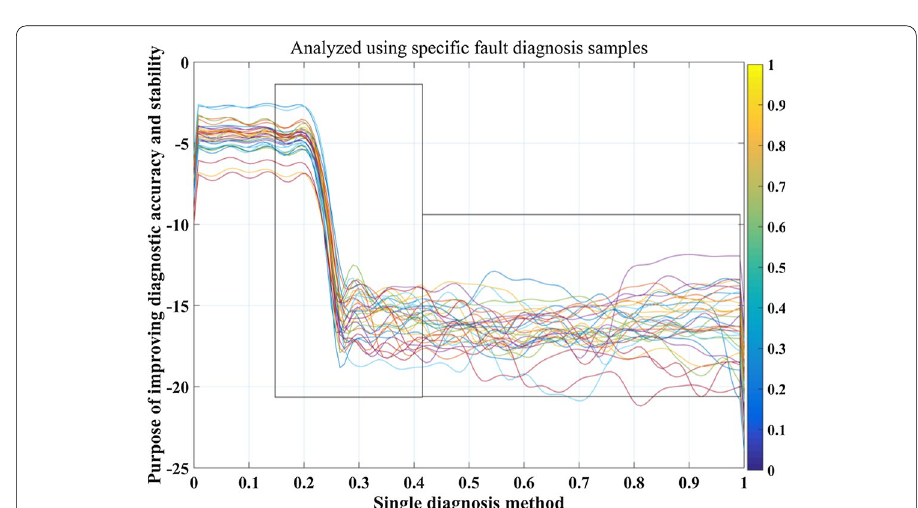
Fig. 10 Analyzed using specific fault diagnosis